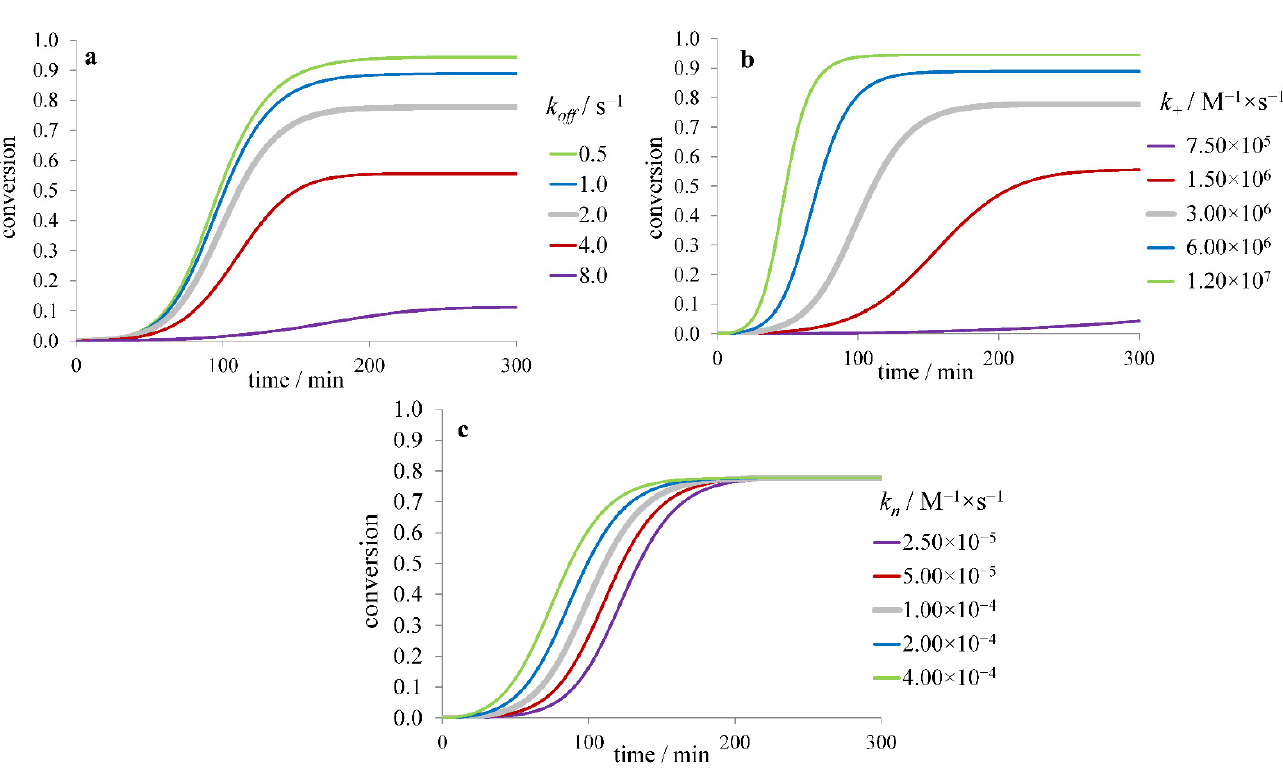
The kinetic curves for different values of α are given in Figure 7. The scaling expo- nents of τ lag , τ 50 , and r max with respect to α depend on the value of